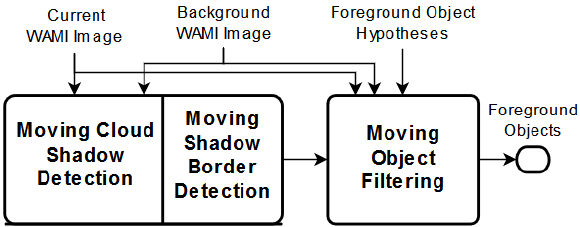
Figure 1. Proposed Method Overall